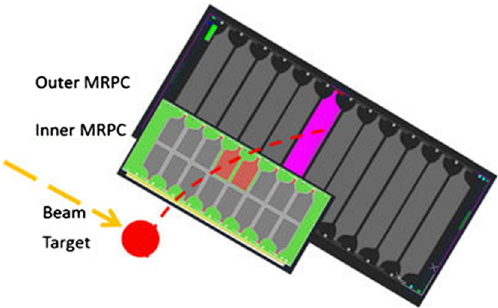
Fig. 20 Event selection: two neighbouring pads of inner MRPC and one strip of the outer MRPC were fired by a single